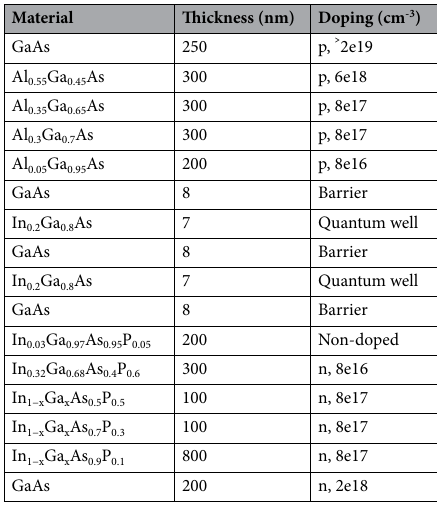
Table 1. 1.06-µm InGaAs dqw laser with asymmetric heterostructure